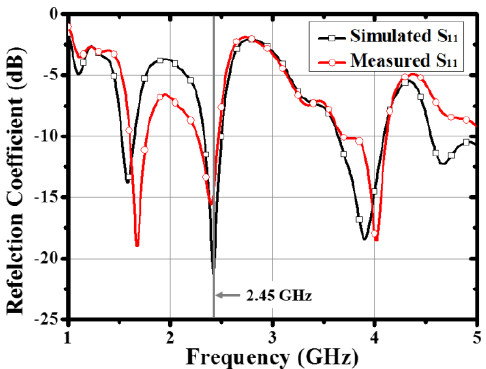
Figure 2. The simulated and measured reflection coefficients for the used TSA antenna.